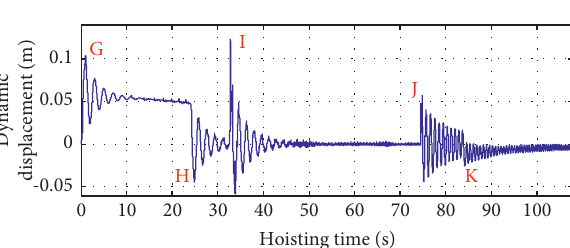
Figure 7: Modeling of longitudinal vibration of hoisting rope.